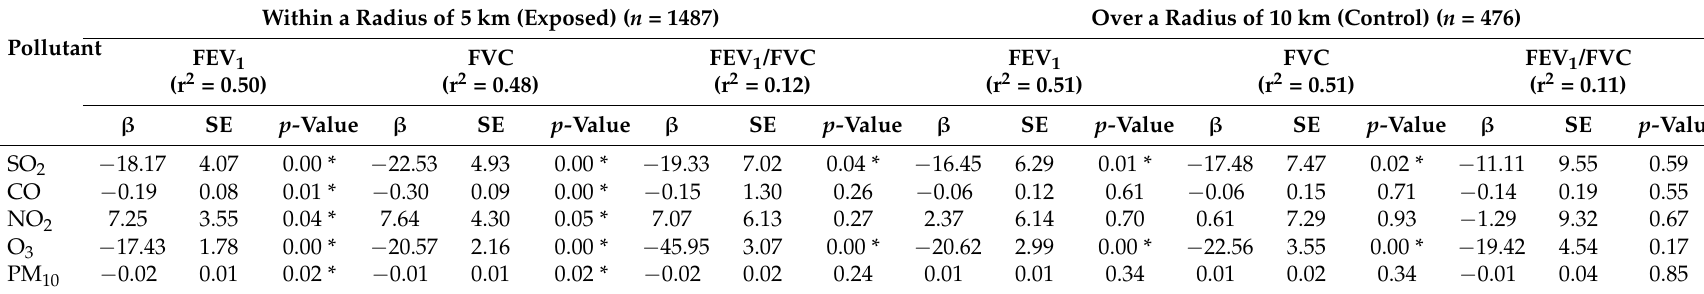
Table 7. Multiple linear regression analysis for pulmonary function levels by air pollutant in each group classified by distance from industrial